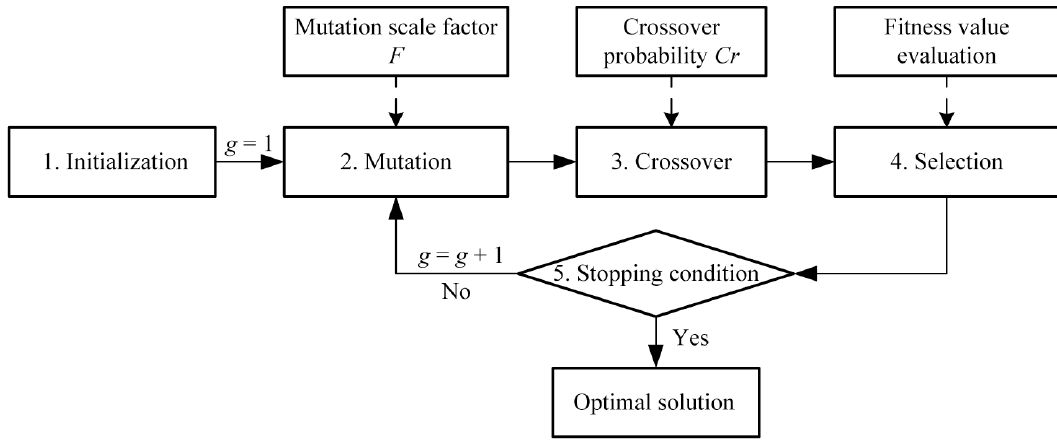
Fig. 2. Differential Evolution optimization